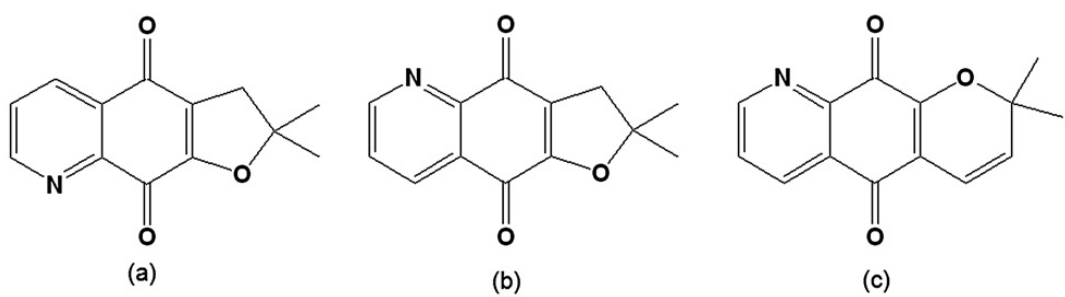
Figure 9. (a) 2,3-Dihydro-2,2-dimethylfuro[3,2- g ]quinoline-4,9-dione; (b) 2,3-Dihydro- 2,2-dimethylfuro[2,3- g ]quinoline-4,9-dione; (c) 2,2-Dimethyl-2H-pyran[2,3- g ]quinoline-